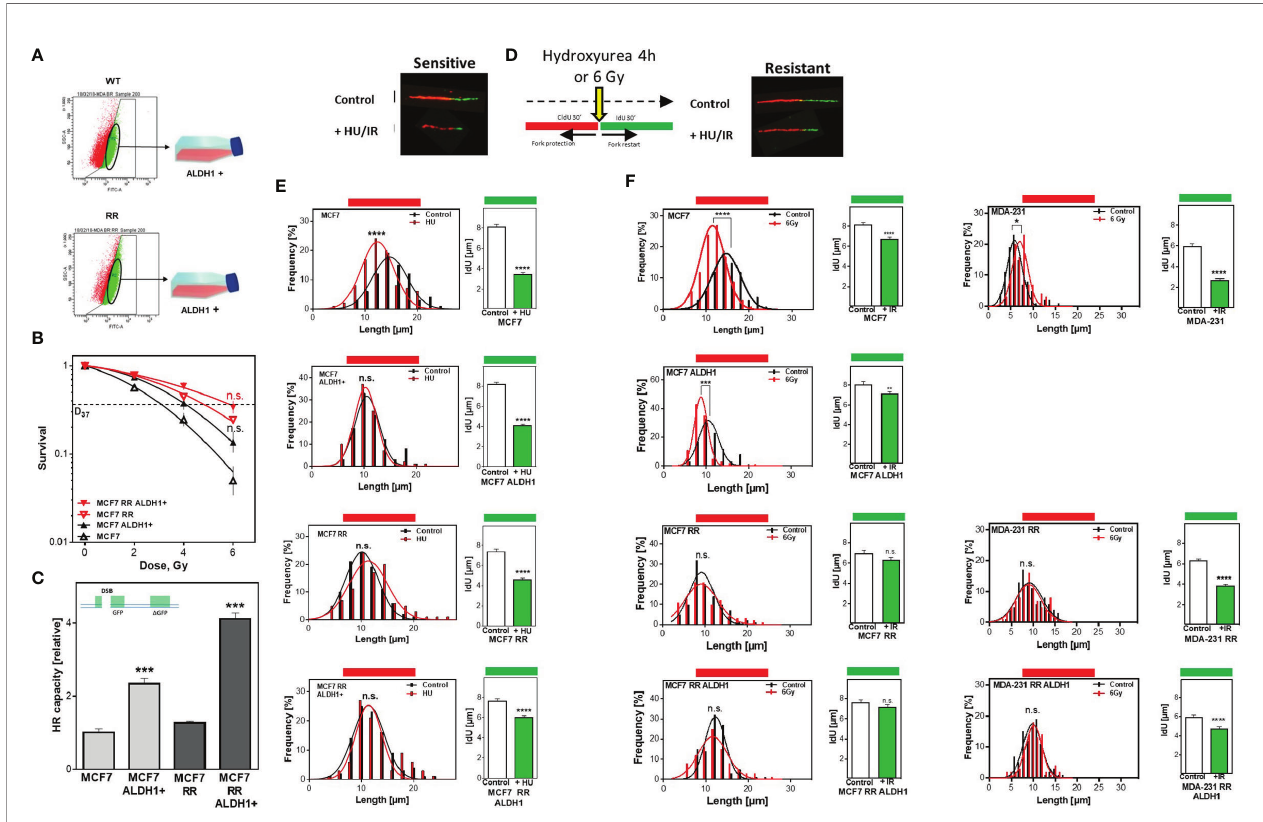
FIGURE 3 | Avoidance of replication stress by functional HR mediates radiation resistance of BCSC. (A) Isolation of ALDH1 positive cells. Cells were treated with ALDEFLUOR ™ reagent, harvested and ALDH1-positive cells isolated by FACS sorting. (B) Cellular survival after irradiation. Cells were seeded 6 hours prior to treatment, irradiated with the indicated doses, fi xed after 14 days and the number of colonies was counted. (C) HR repair of DSB. Cells were transiently transfected with the linearized pDR-GFP construct for 24h. The number of GFP-expressing cells was analyzed by FACS and HR capacity of the ALDH1 positive cells was normalized to their respective parental cell lines. (D – F) Replication tract lengths after HU or irradiation. MCF7 cells were sequentially labelled with CldU and IdU for 30min and either treated with HU or MCF7 and MDA-MB-231 cells irradiated with 6 Gy between both labels. DNA was spread on slides, fi xed, and incorporated nucleotides were detected by immuno fl uorescence. The lengths of the DNA fi bers were measured with the Image J software. Shown are means of three independent experiments ± SEM. Asterisks (*) represent signi fi cant differences (n.s., not signi fi cant; *p < 0.05; **p < 0.01; ***p < 0.001, ****p < 0.0001, Student ’ s